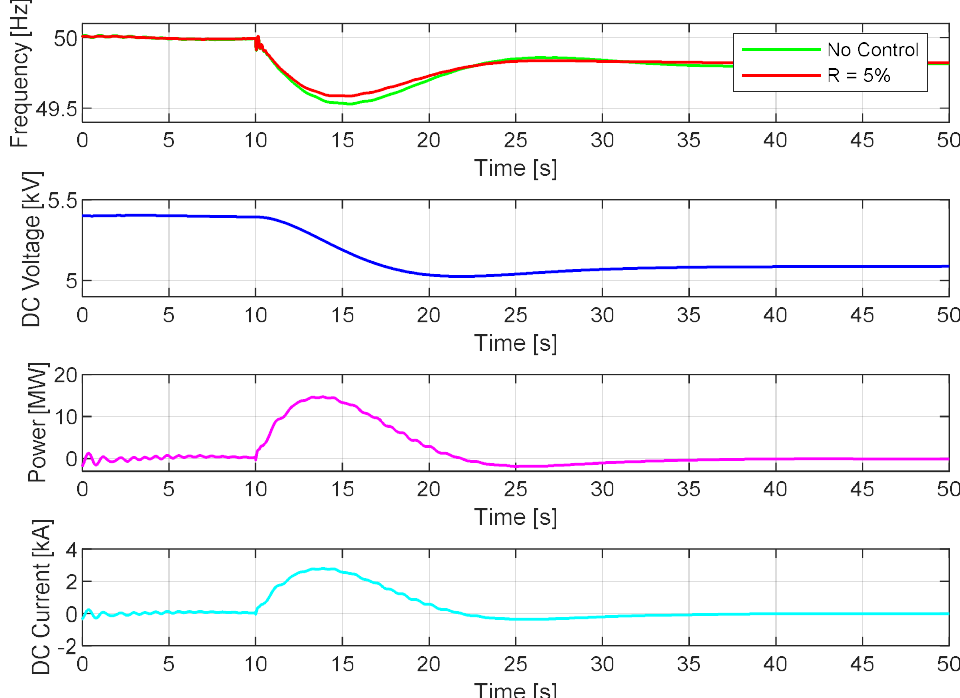
Figure 7. FFR provision from the directly-connected SC (from top to bottom: system frequency, SC terminal DC voltage, SC output DC power, SC output DC